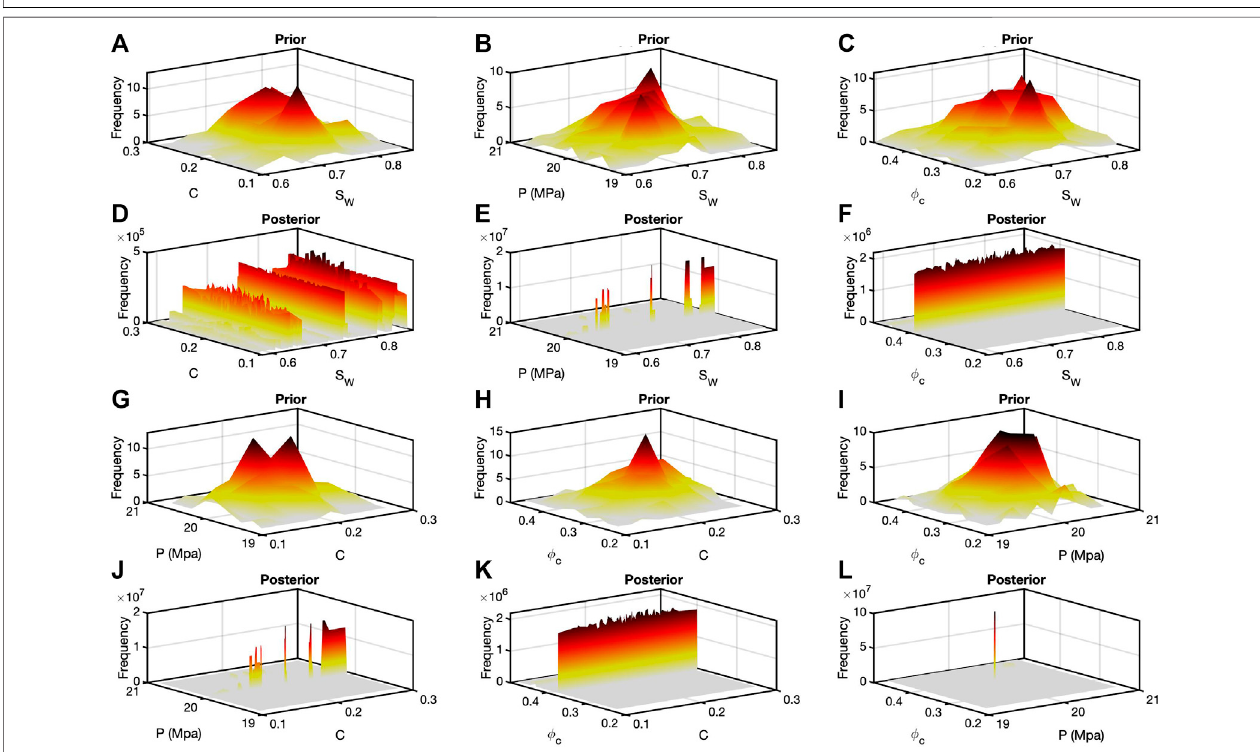
FIGURE8| Analysisfour,forgassands,resultedinsimilarbivariatehistogramscomparedwiththosein Figure7 .However,thefrequenciesareconsiderablylower.Thisis the result ofthe prior model not being as close to the data as they were in the other inversions. Nonetheless, the patterns repeated themselves among the different posteriors.